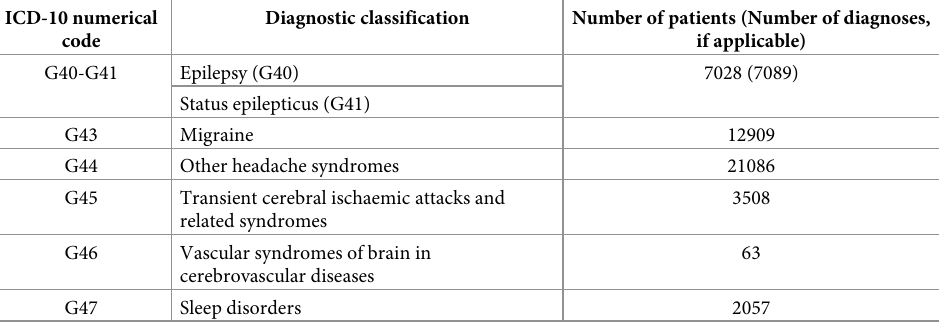
Table 2. Number of patients with G40-G47 diagnoses received in 2004–2016 prior to first pregnancy during the study period.